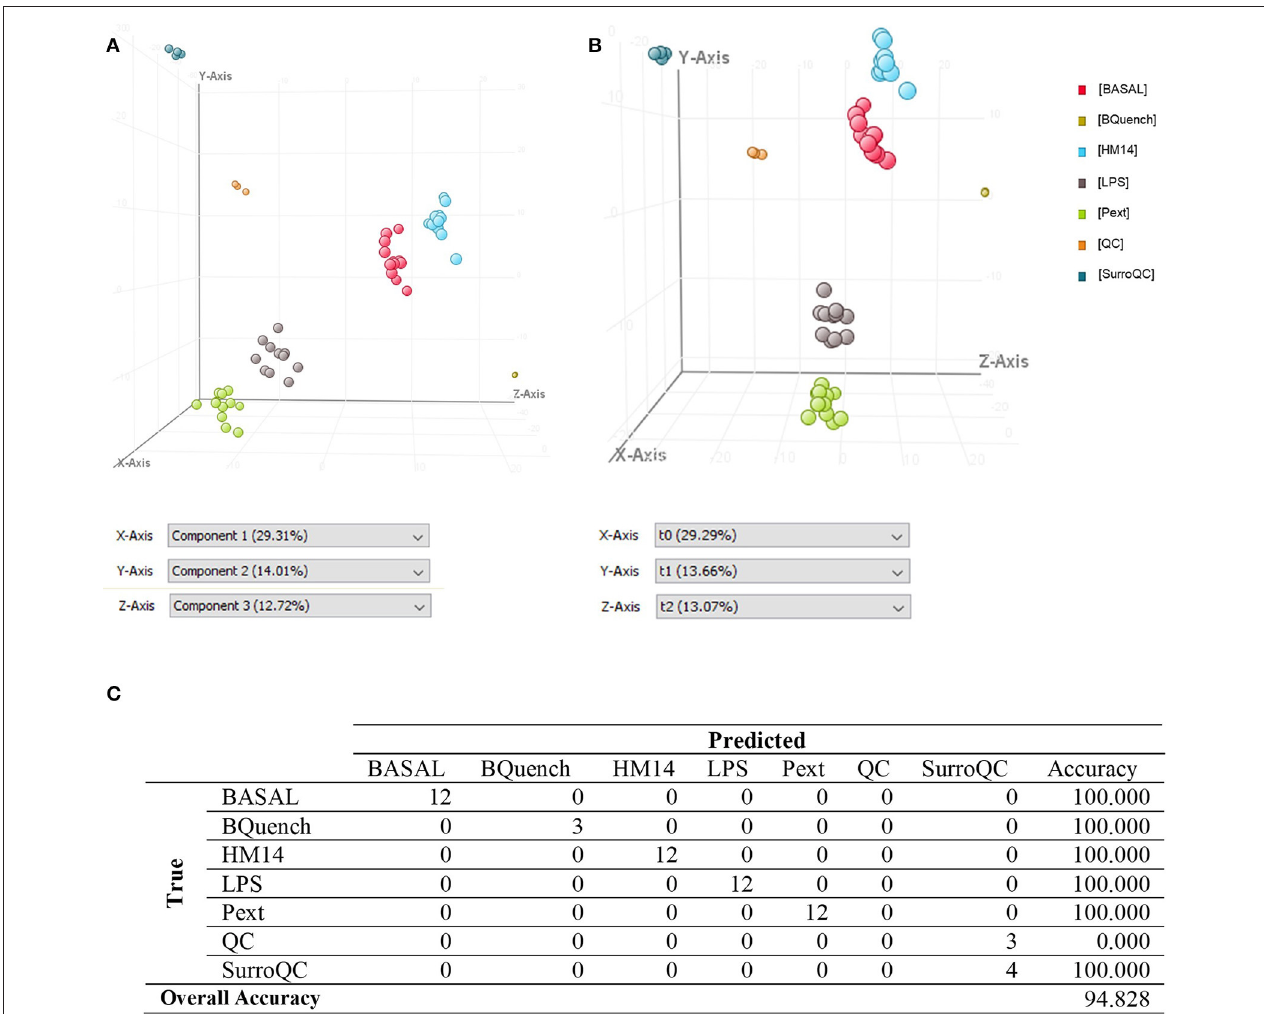
FIGURE 4 | (A) Three-dimensional PCA score plot, (B) PLS-DA score plot and (C) Confusion matrix of the PLSDA